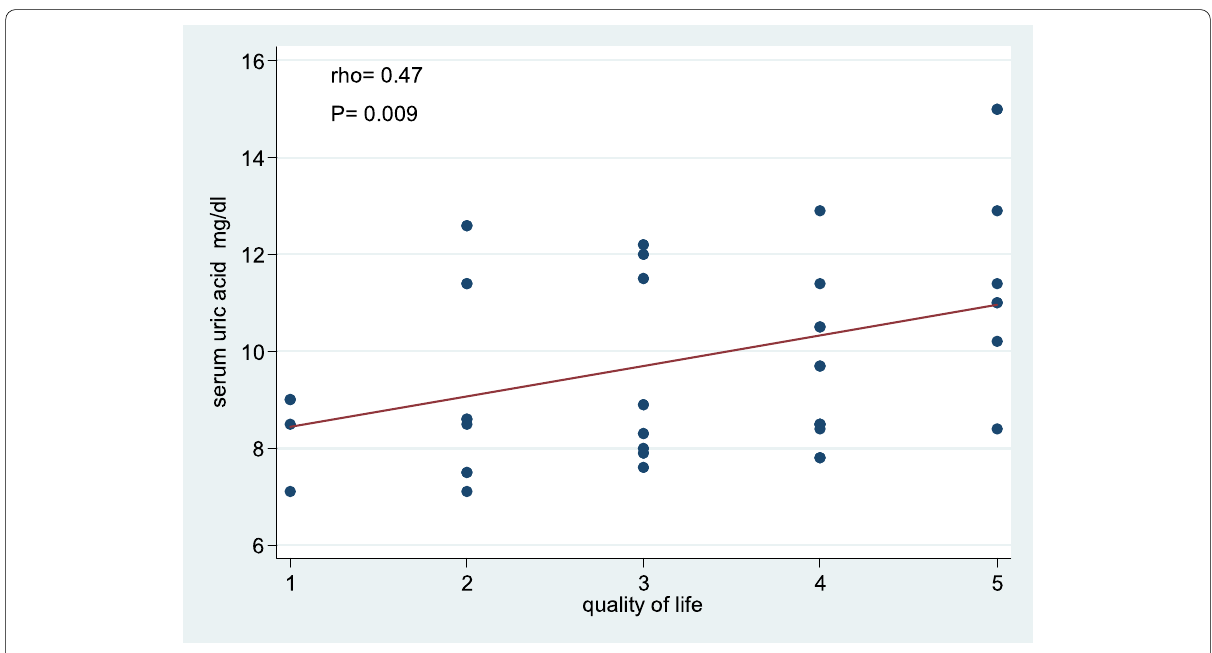
Fig. 1 Correlation between quality of life and serum uric